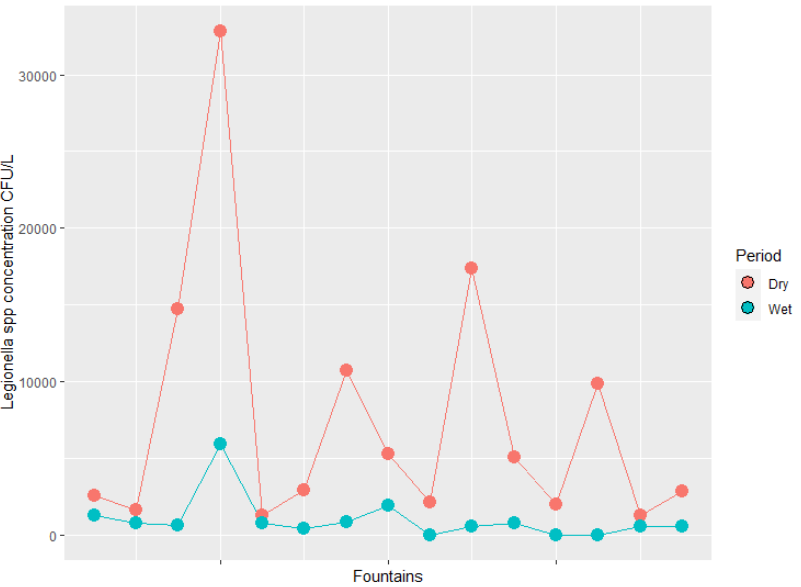
Figure 3. Legionella spp. concentration (on a logarithmic scale) correlated with season.